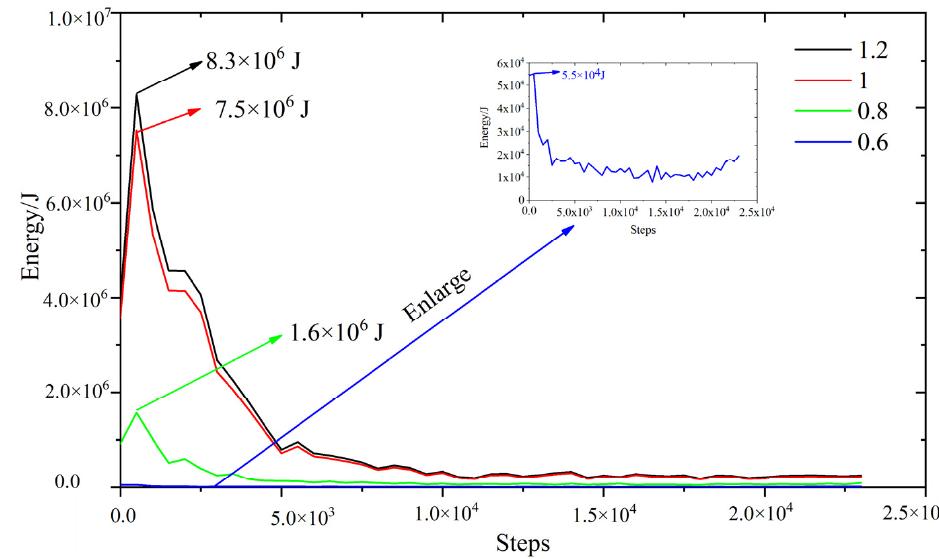
Figure 9. Kinetic energy curves of roof fracture with different shear strength.